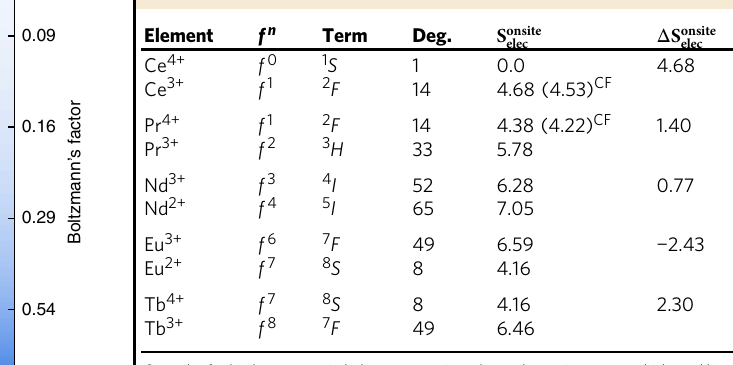
Once the f -orbitals are occupied, the system gains a large electronic entropy which weakly depends on its occupation number. Therefore, the largest Δ S onsite elec per oxygen vacancy is associated with the f 0 → f 1 transition, where fully oxidized state has zero entropic contribution. Entropy units are in k